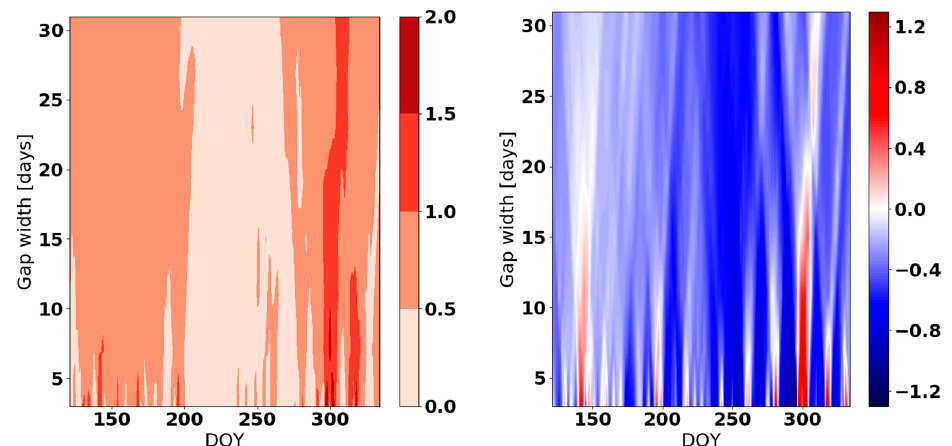
Figure A8. RMSE DEB ( left panel ) and (RMSE DEB -RMSE ERA5 ) difference ( right panel ) calculated using daily data calculated using daily data for DOY 121–334 2017 in Bahariya.